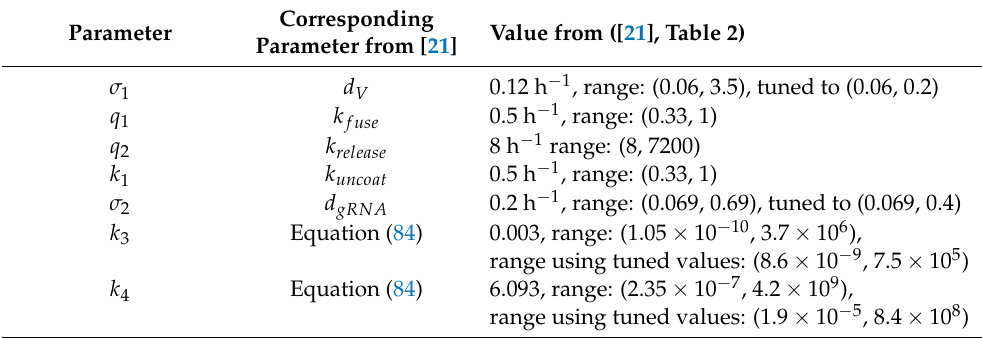
Table 1. Parameter estimation for the model (1)–(5). Ranges for the parameters k 3 and k 4 are calculated using respective ranges for parameters from ([21], Table 2, p. 9) and Formula (84). Corresponding Value from ([21], Table Parameter Parameter from [21]